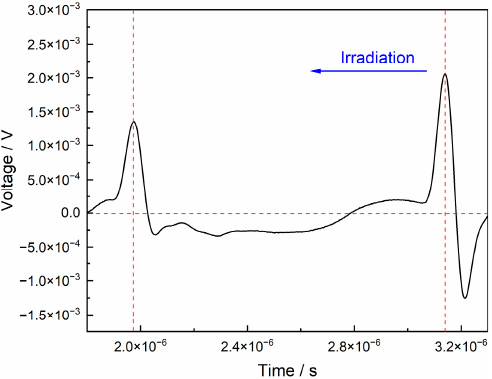
Figure 6. Original voltage waveform of in-site PEA method under 1.3 MeV electron radiation.